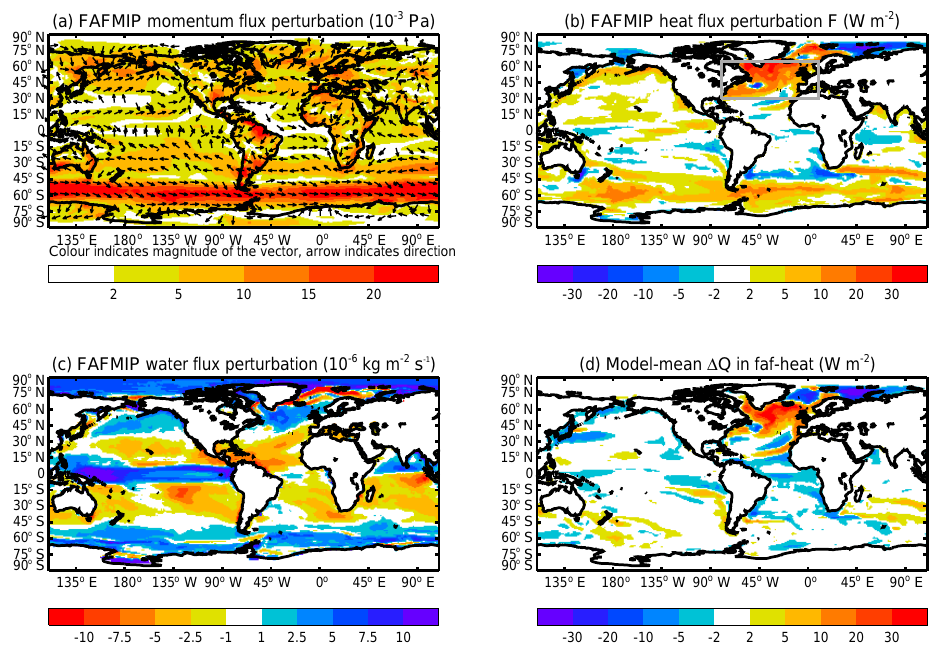
Figure 2. Annual-mean FAFMIP surface flux perturbations of (a) momentum, (b) heat, (c) water; (d) shows the model-mean change in the surface heat flux Q into the seawater in the time mean of the final decade of the faf-heat experiment relative to the control, not including the imposed heat flux perturbation F . The ocean area average of (b) is 1.86Wm − 2 , of (c) 0 . 072 × 10 − 6 kgm − 2 s − 1 and of (d) 0.07Wm − 2 . The grey box in (b) is the North Atlantic region to which we refer in Sect. 3.1.